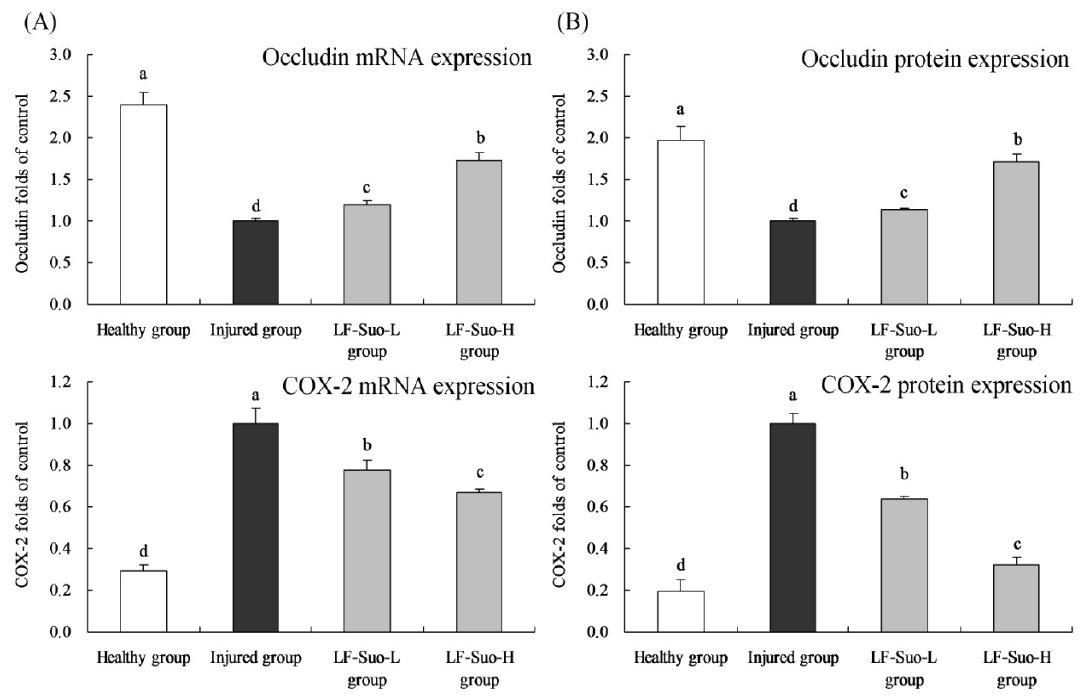
Figure 2. Occludin, COX ‐ 2 mRNA ( A ) and protein ( B ) expression of studied mice. Fold ‐ ratio: gene expression/GAPDH ( β‐ actin) × injured group numerical value (injured group fold ratio: 1). a–d Mean values with different letters in the same column are significantly different ( p < 0.05) according to Duncan’s multiple ‐ range test.